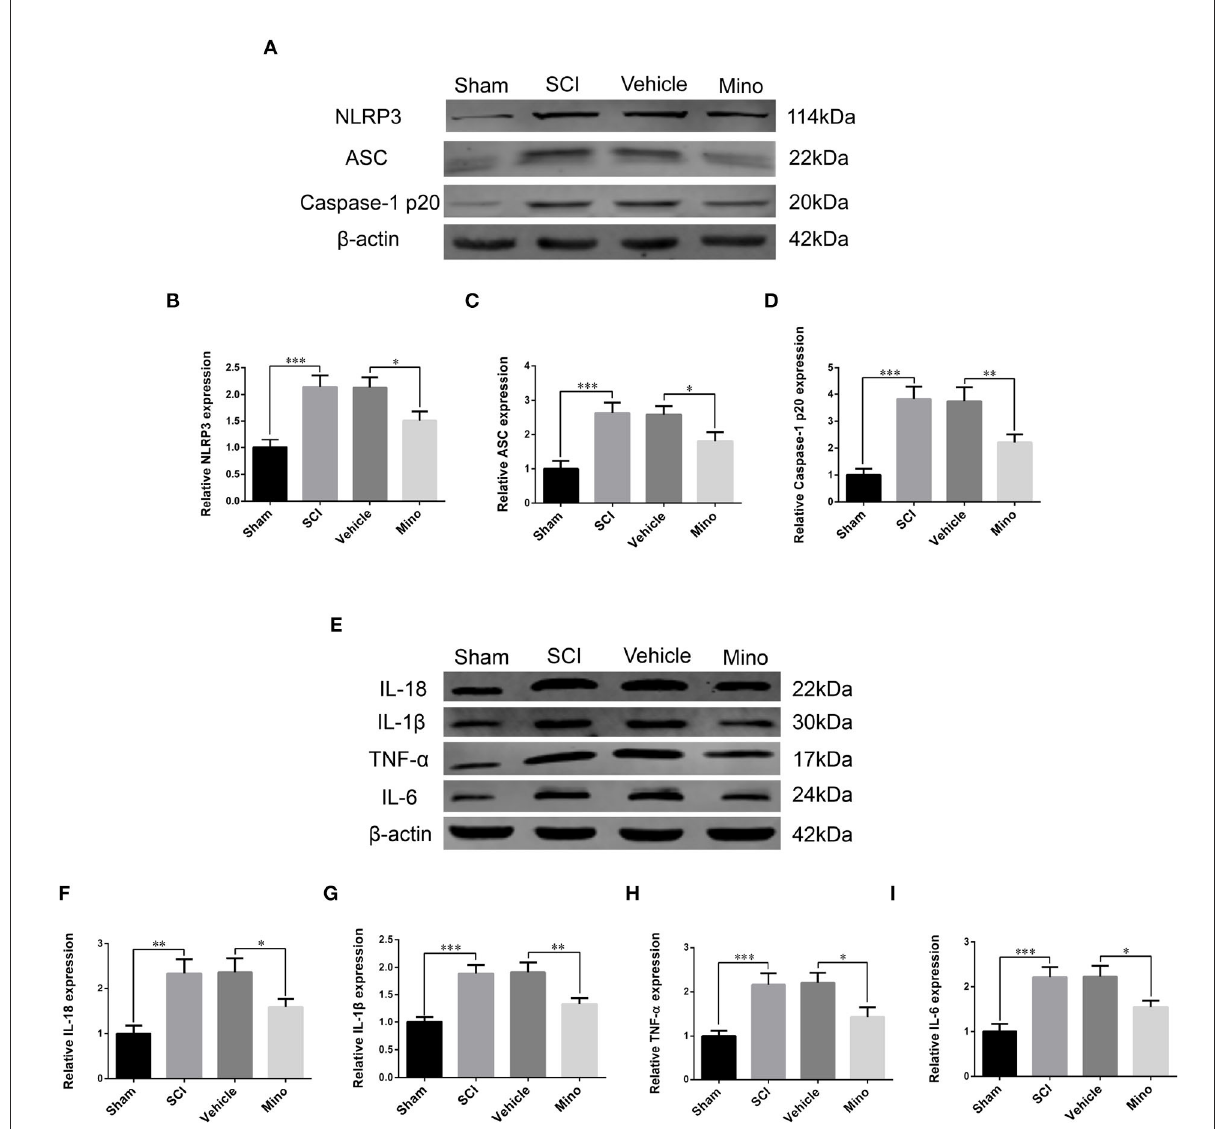
FIGURE2 Western blot (WB) detected NLRP3-related neuroinflammation in M1. (A) Representative immunoblots of NLRP3, ASC, and caspase-1 p20 in M1 of each group. (B–D) Quantitative analyses of NLRP3, ASC, and caspase-1 p20 expression in M1 of each group. (E) Representative immunoblots of IL-18, IL-1 β , TNF- α , and IL-6 in M1 of each group. (F–I) Quantitative analyses of IL-18, IL-1 β , TNF- α , and IL-6 expression in M1 of each group (data were presented as means ± SD, n = 3, * p < 0.05, ** p < 0.01, *** p <